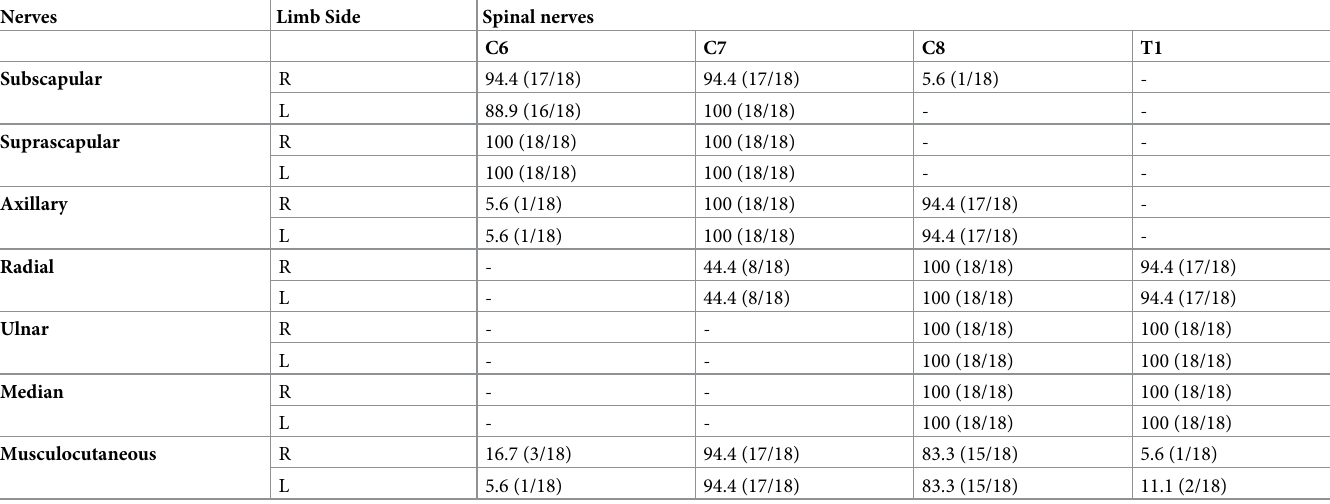
The percentages and numbers (in parentheses) of the right (R) or the left (L) thoracic limbs in which each spinal nerve (from C6 to T1) contributed to the formation of each nerve of the brachial plexus obtained from 18 canine cadavers are